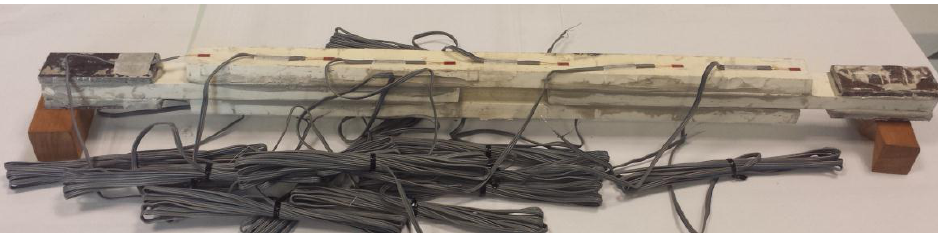
Figure 8. Joint sample “II” (after strain gauges application).